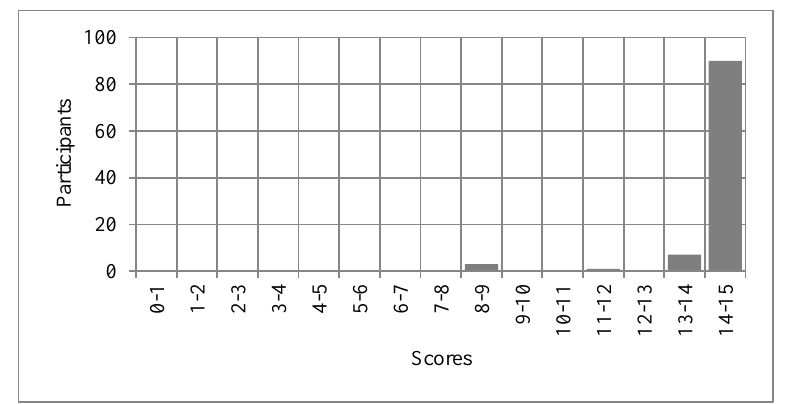
Fig. 3. Testing results on the topic "Magnetic Field in a Vacuum" for performing all test tasks with an extended time for solving tasks.